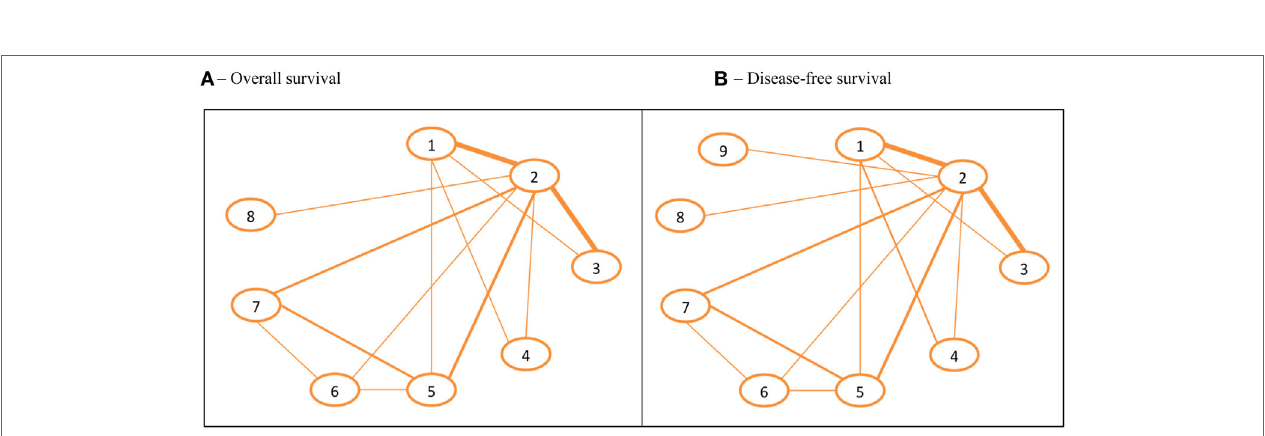
FiGURe 1 | Adapted PRISMA flow diagram. * Indexed literature research: EMBASE, Central (COCHRANE) and PubMed. ** non-indexed literature: American Society od Cinical Oncology (ASCO), San Antonio Breast Cancer Symposium (SABCS). European Society for Medical Oncology (ESMO), St. Gallen International Breast Cancer